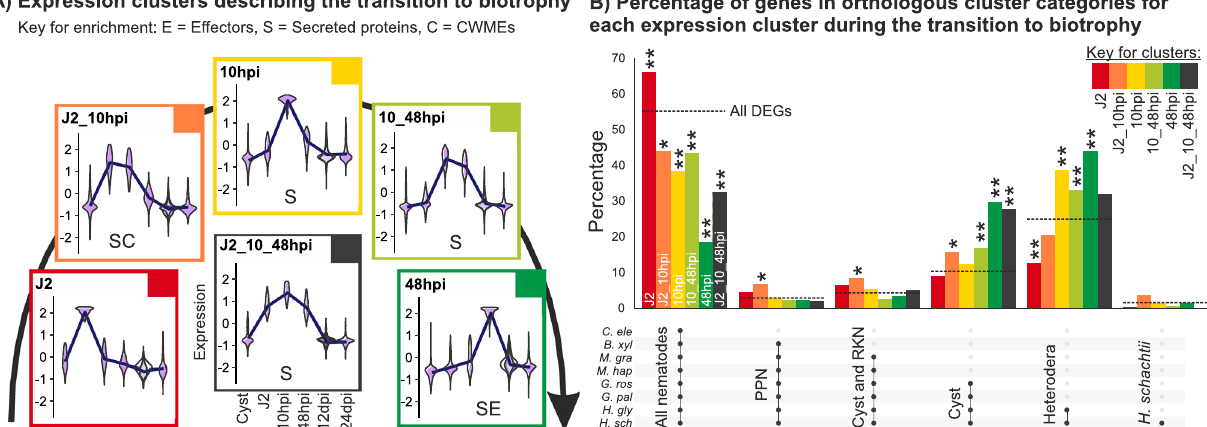
Fig. 4 | H. schachtii genes deployed during the transition to biotrophy are variously conserved with cyst nematodes. A The expression pro fi les of six superclusters describe the transition to biotrophy. Those clusters enriched in putatively secreted proteins (S), effectors (E), and cell wall modifying enzymes (C) are shown (e.g., SE denotes a cluster enriched in putatively secreted proteins and effectors). N.B. effectors and cell wall modifying enzymes are also putatively secreted proteins. B For each cluster, the proportion of genes present in each orthologous gene cluster category is shown for the following species